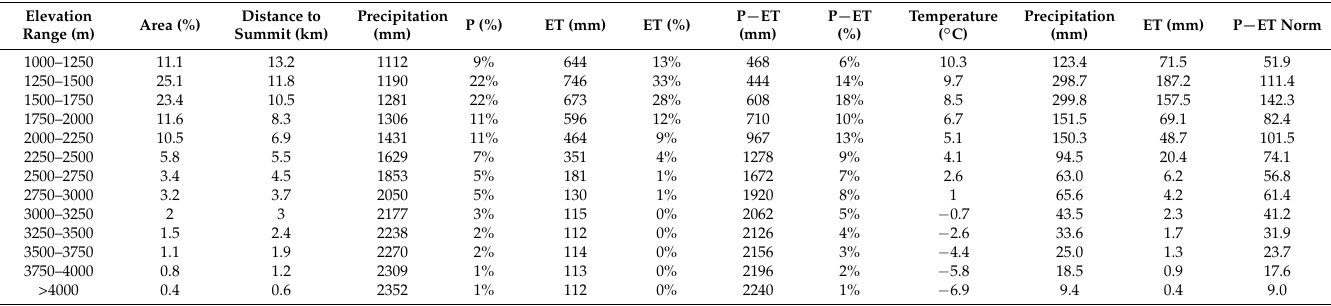
Table A4. Results of Spatial Analysis.